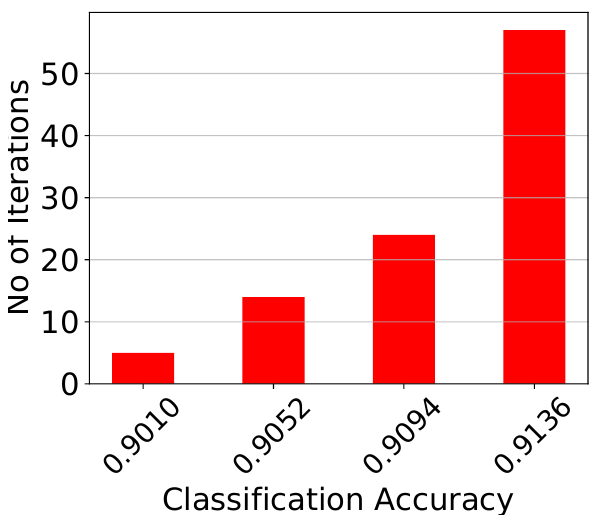
Figure 15. Monte Carlo histogram on the voting classifier’s accuracy for N = 100 points.